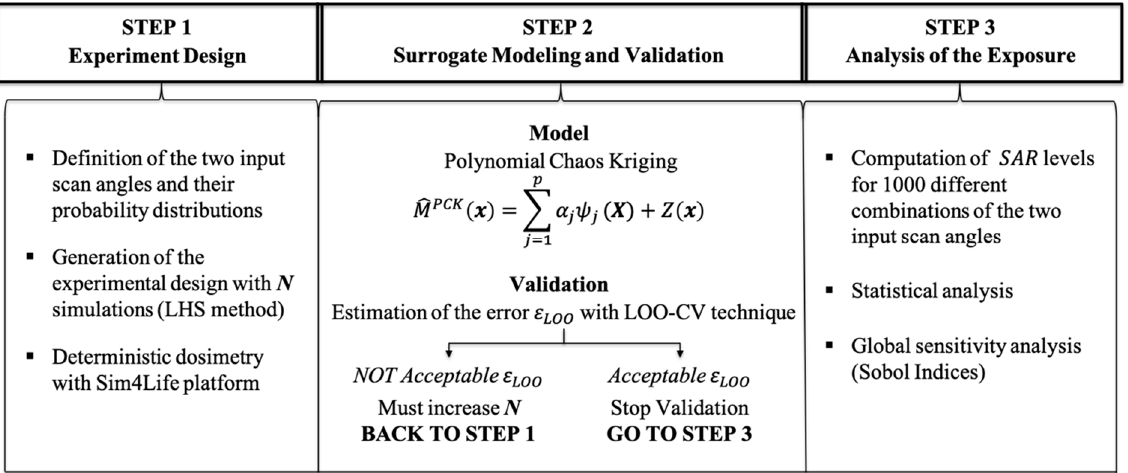
Figure 3. Schematic workflow of the methodology used in the paper for conducting the exposure assessment.